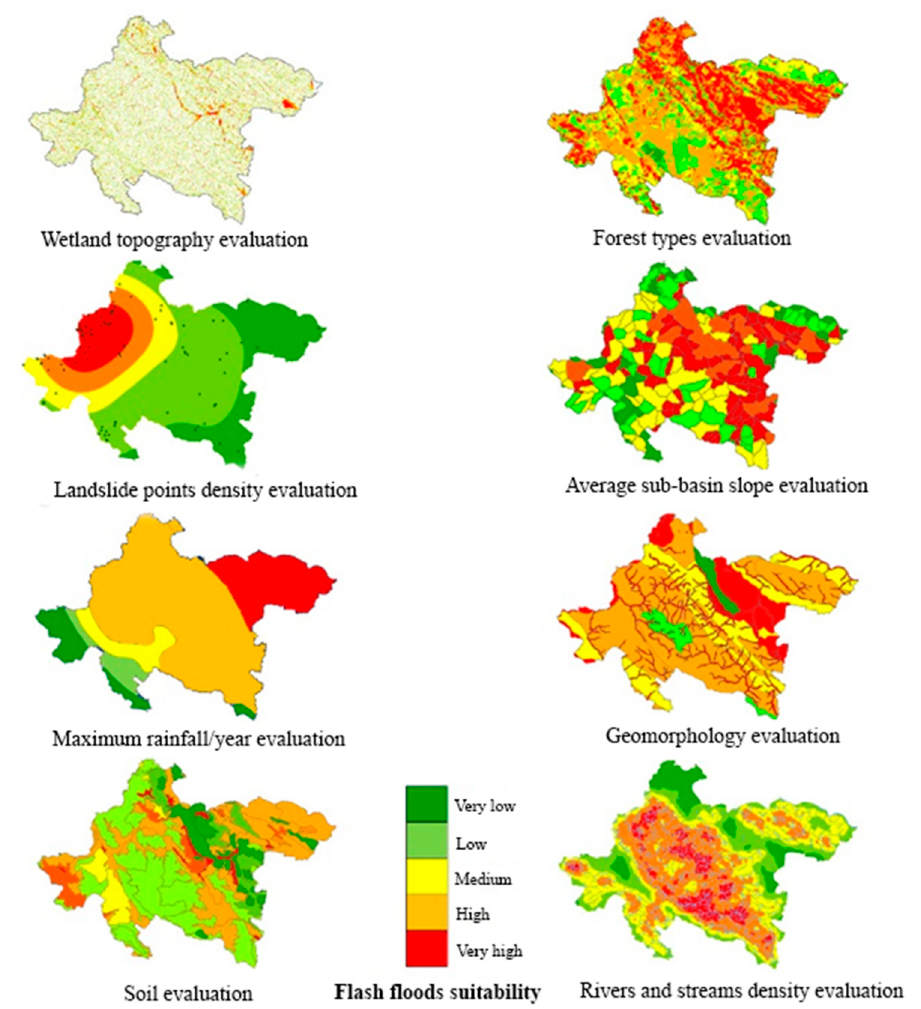
Figure 3. Evaluation of flood risk information layers in the Thuan Chau